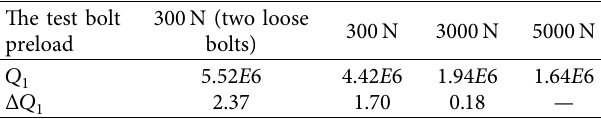
Table 6: Q and Δ Q of the connection structure with 6 bolts under 1 1 1500N impact load with standard preload of 4000N and loose bolt preload of 300N.